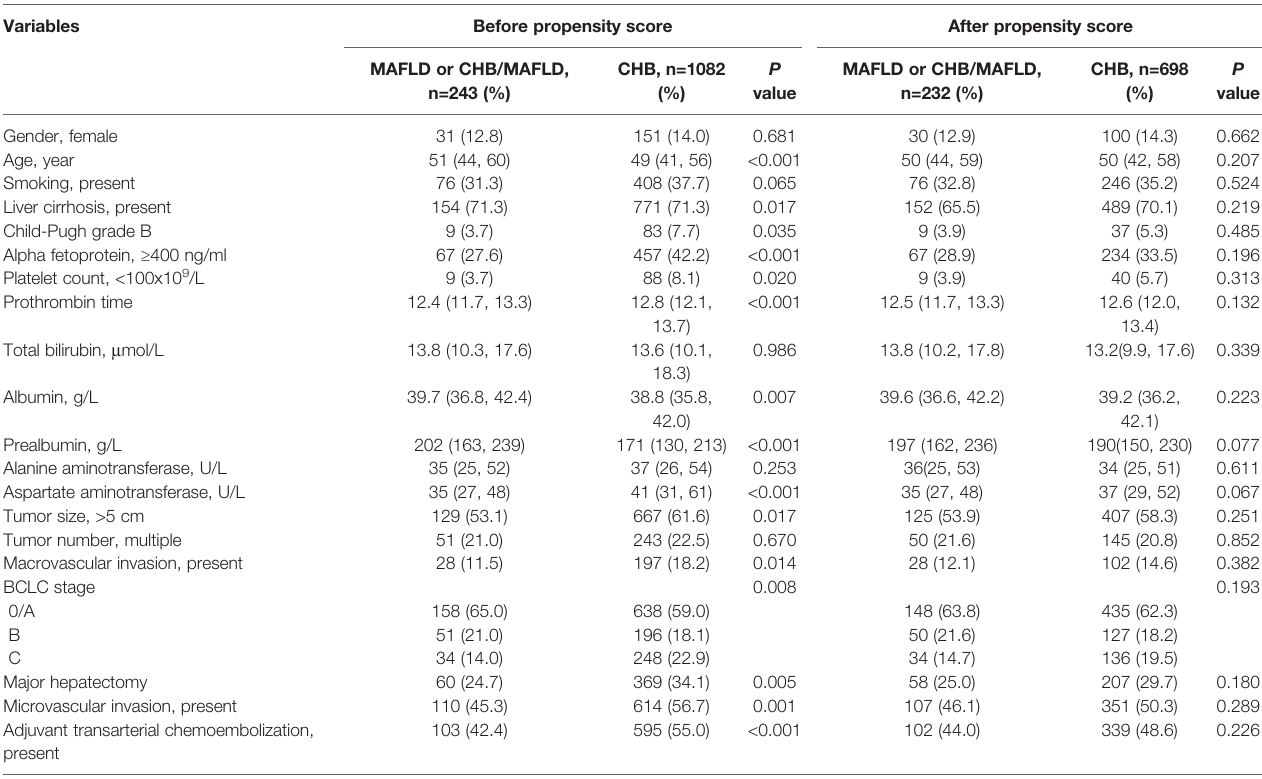
TABLE 4 | Baseline demographic and clinical characteristics of patients with MAFLD+CHB/MAFLD or CHB. Variables Before propensity score After propensity score MAFLD or CHB/MAFLD, n=243 (%)